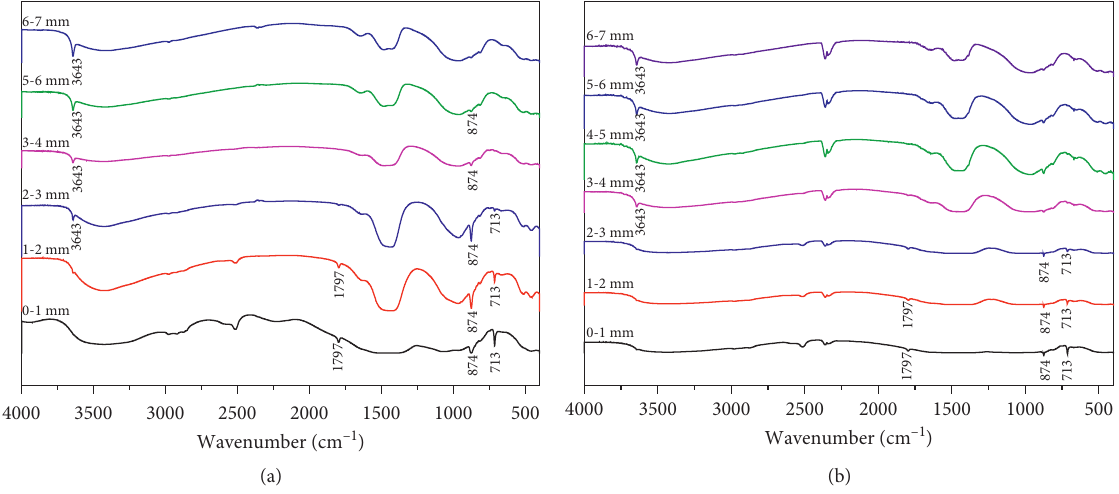
Figure 14: Infrared curves of samples in the mineralization group (a) and carbonization group